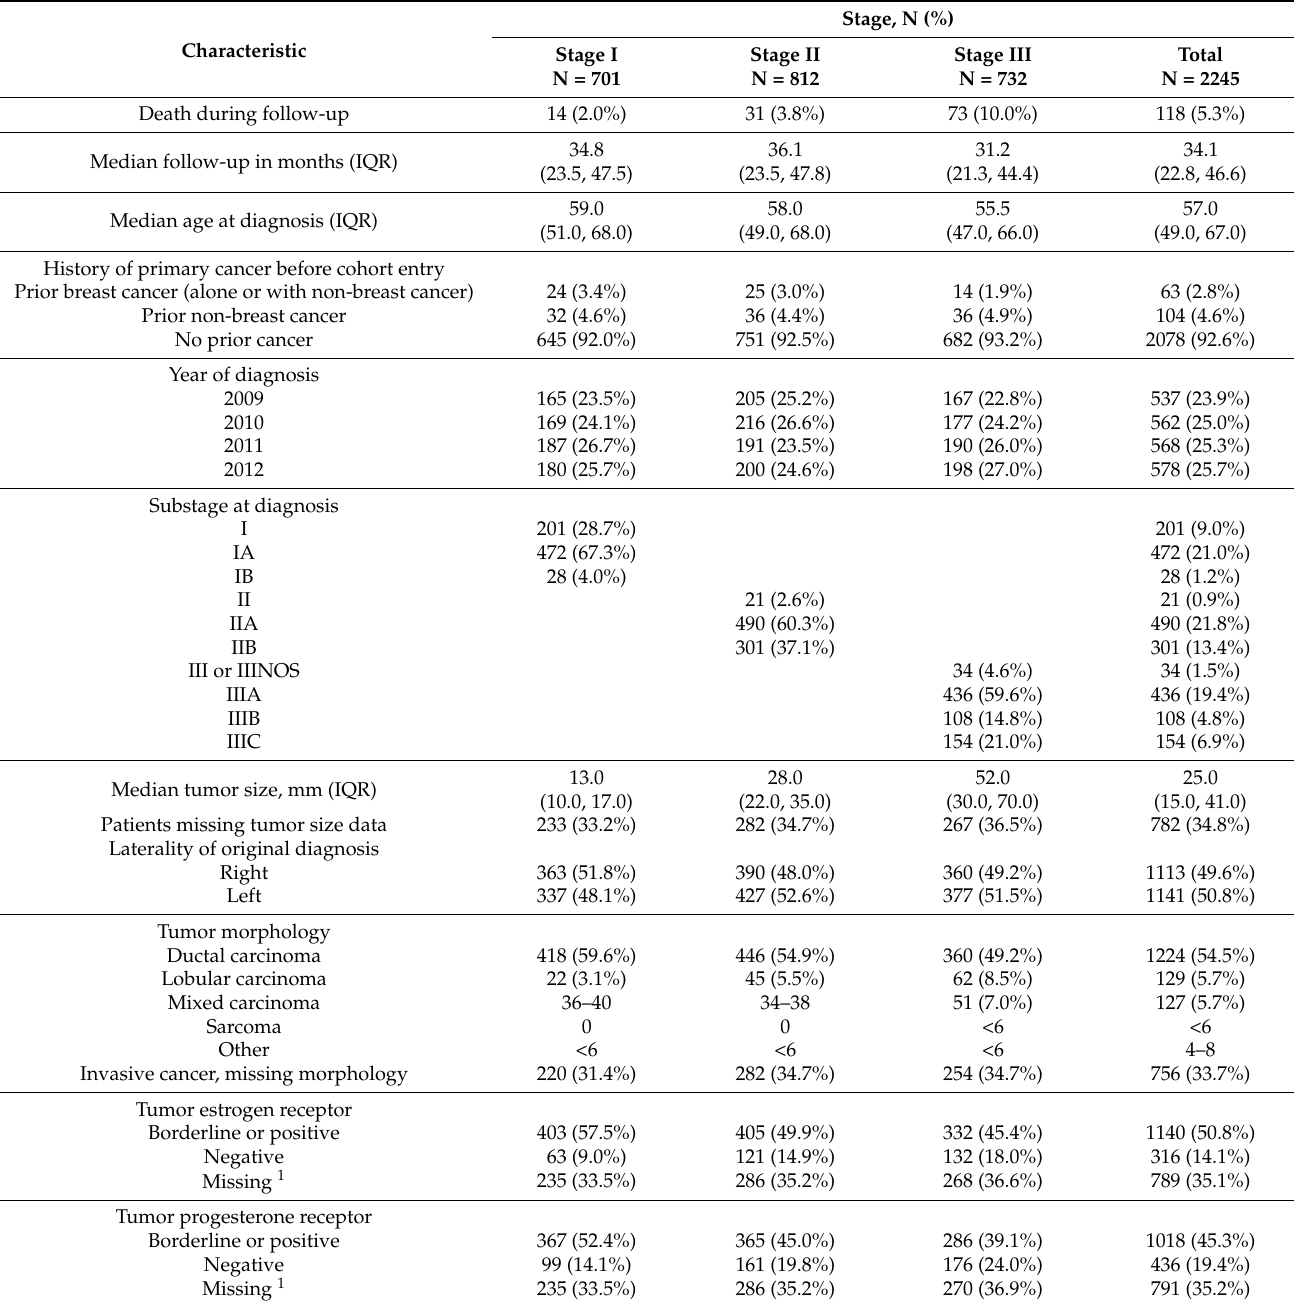
Table 3. Validation sub-cohort